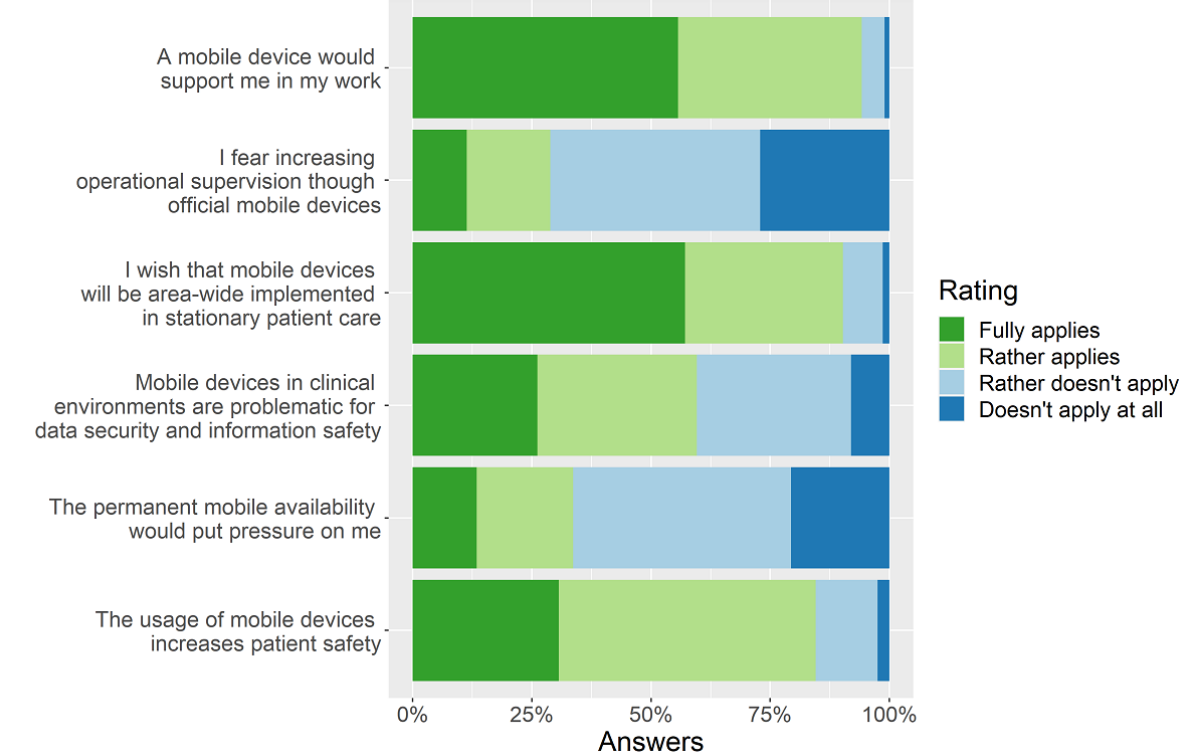
Figure 2. Personal opinion about mobile devices.